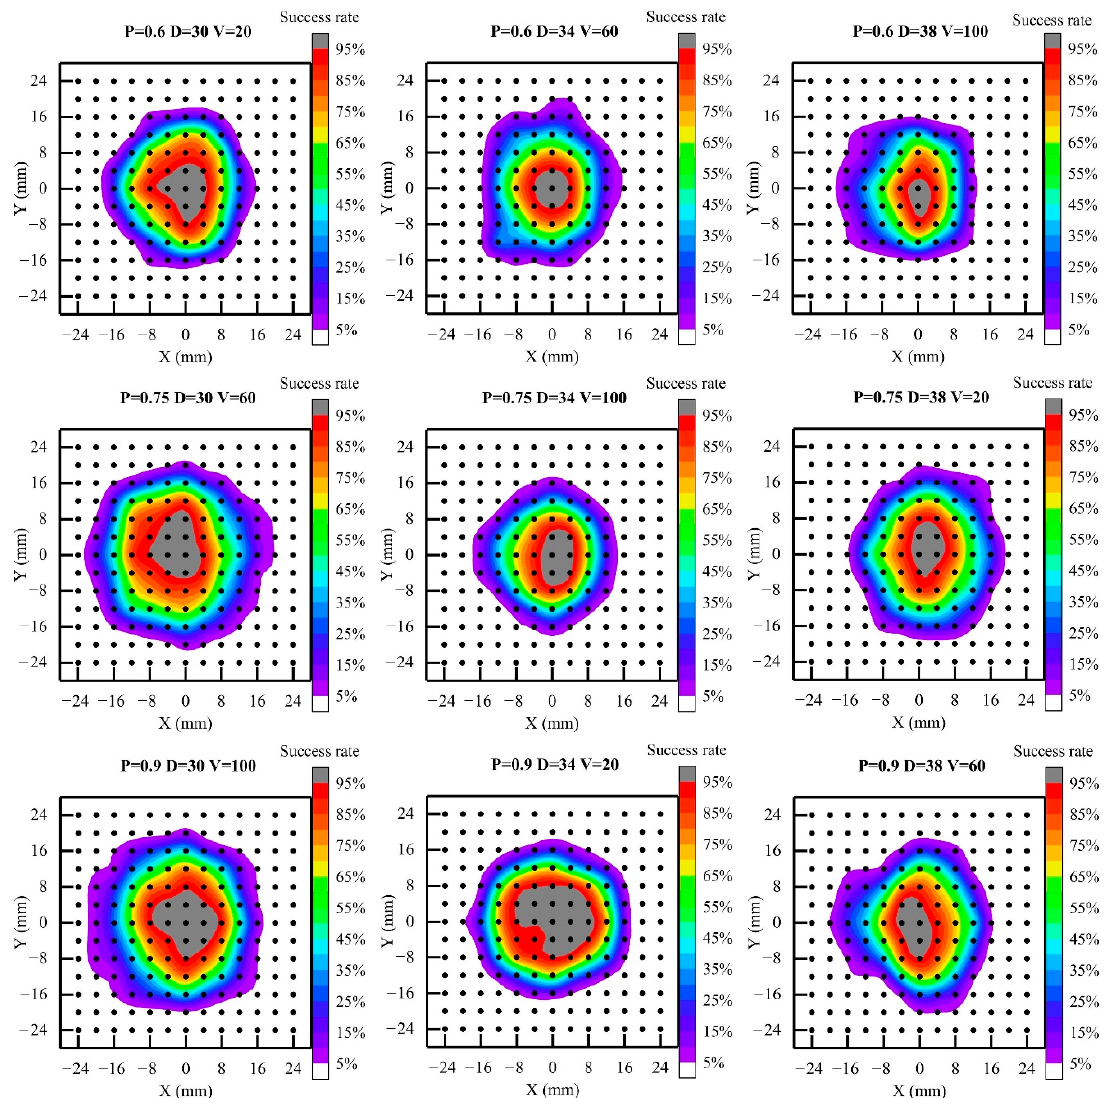
Figure 19. Diagram of deviation tolerance effect.